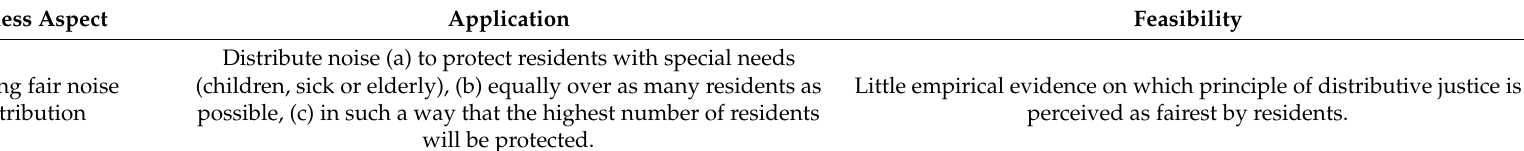
Table 1. Summary and practical implementation of fairness